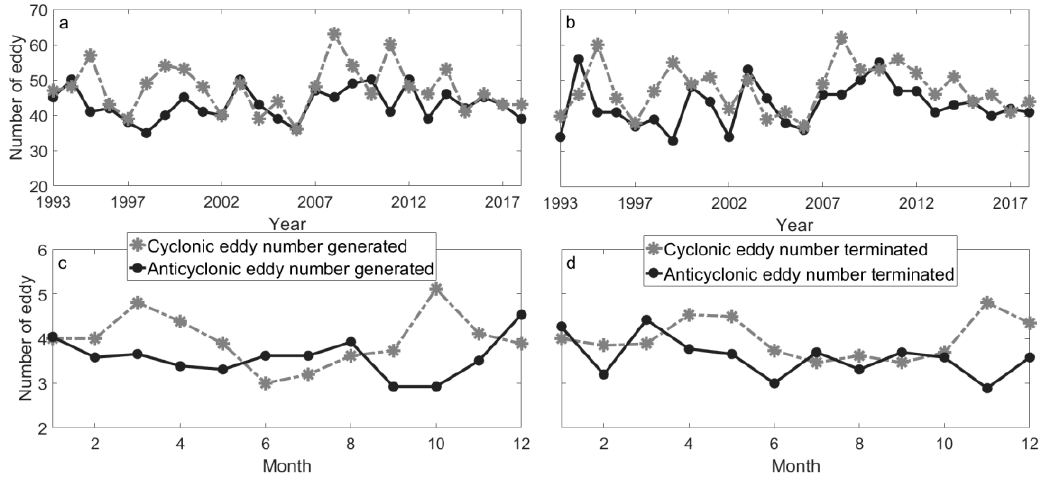
Figure 12. The interannual variation of the number of ( a ) generated and ( b ) dissipated eddies. The seasonal variation of the number of ( c ) generated and ( d ) dissipated eddies. Gray lines identify CEs, while black lines demarcate AEs.